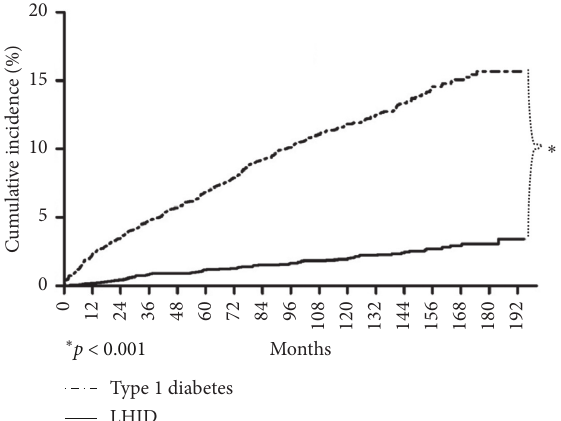
Figure 2: The cumulative incidence of cataracts in the type 1 diabetes group vs. the Longitudinal Health Insurance Database (LHID) group.